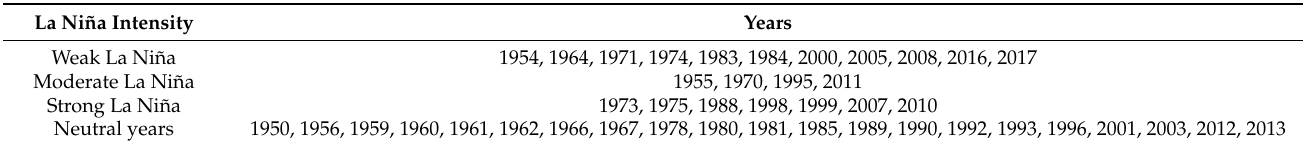
Table 2. Years associated with La Niña from 1950 to 2018.